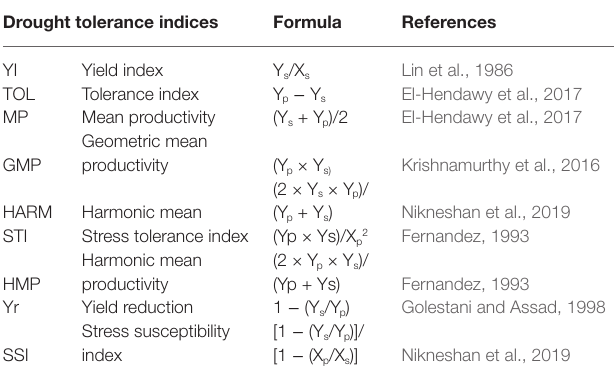
TABLE 1 | Description of the drought tolerance indices based on tuber